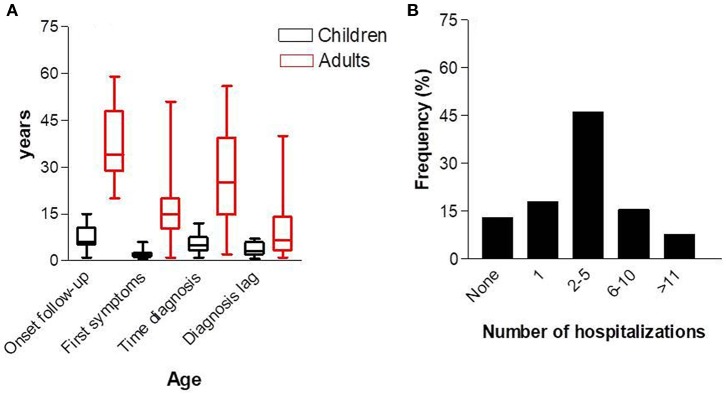
Age at first consultation, age of first symptoms, and diagnosis (A), and number of hospitalizations (B).